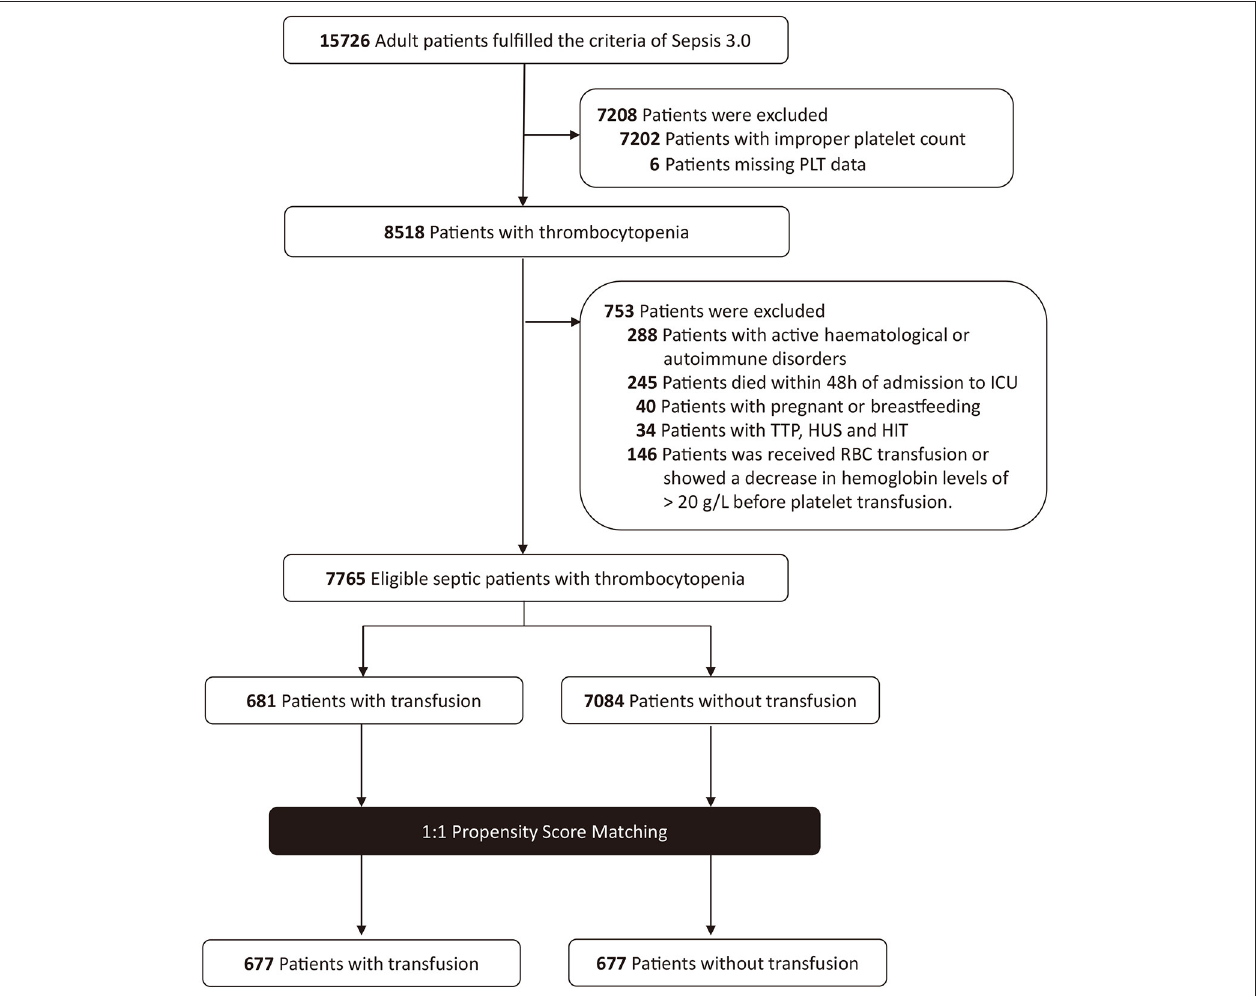
FIGURE 1 | Study population flow diagram. PLT, platelet; TTP, thrombotic thrombocytopenic purpura; HUS, hemolytic uremic syndrome; HIT, heparin-induced thrombocytopenia; RBC, red blood cell.